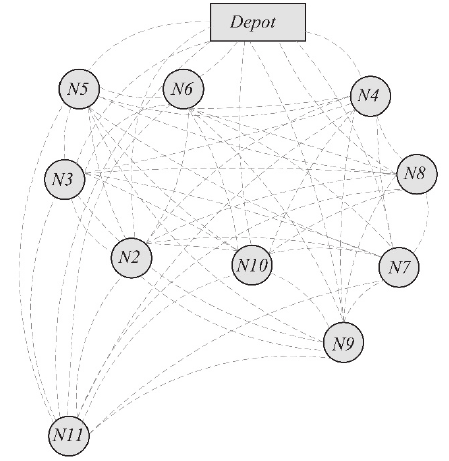
Fig. 3. Graph of the routing problem